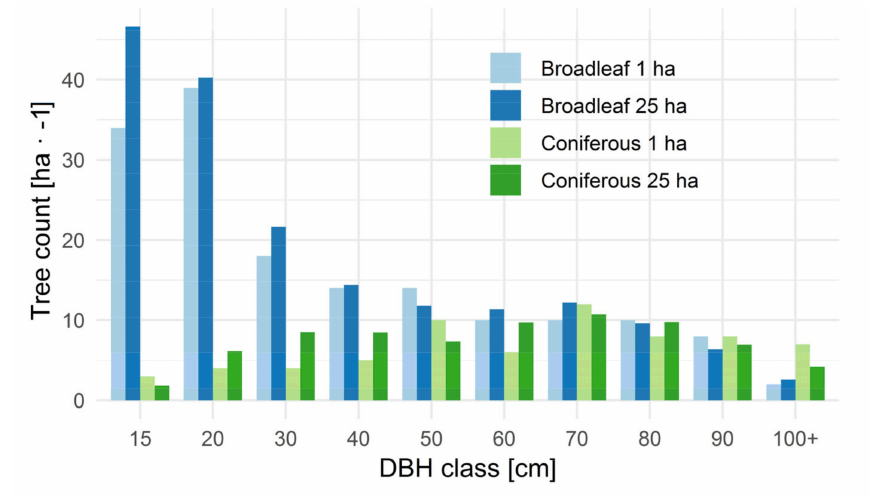
Figure 1. DBH distribution of trees on the 25 ha of ZFDP and on the 1 ha subplot covered by